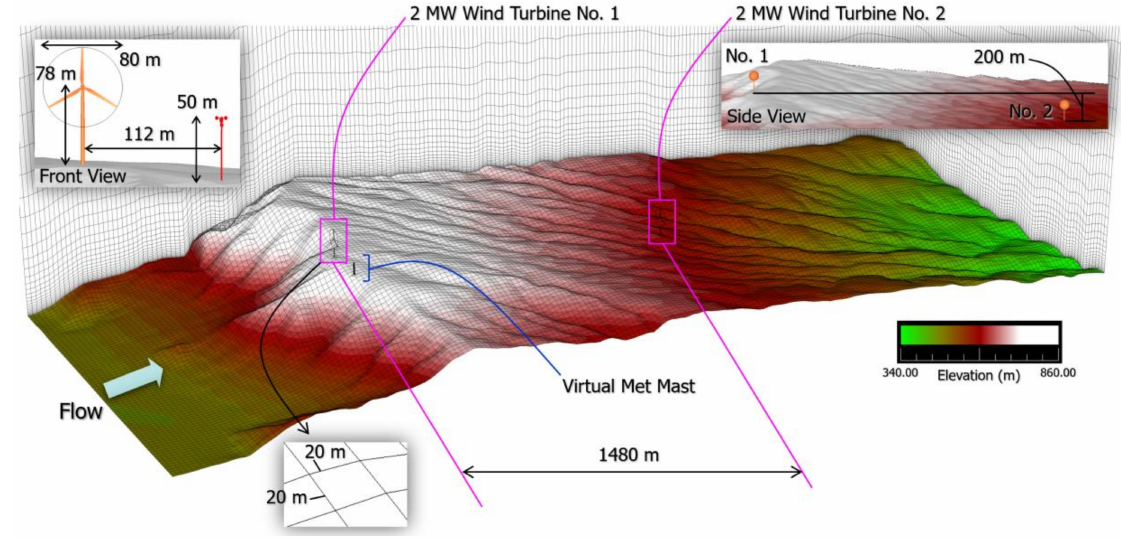
Figure 20. Topographical conditions around the locations of the wind turbines.